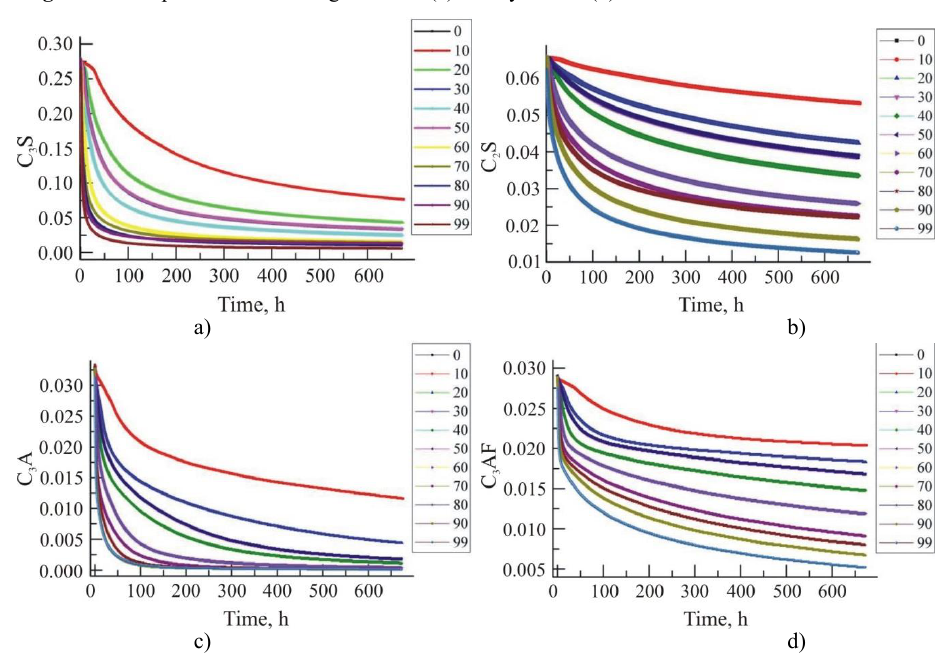
Fig. 2 . Time dependencies of clinker phase fractions: a – alite (C 3 S); b – belite (C 2 S); c –